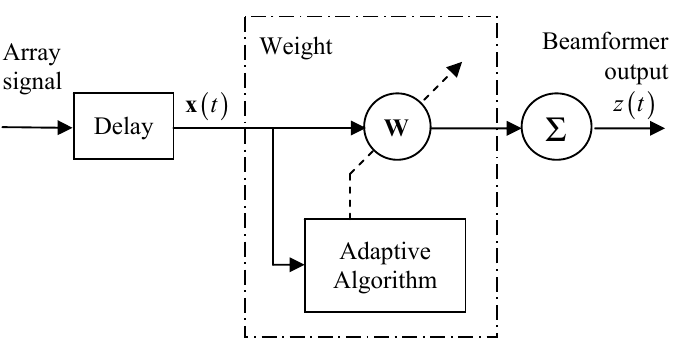
Figure 2. Schematic of adaptive